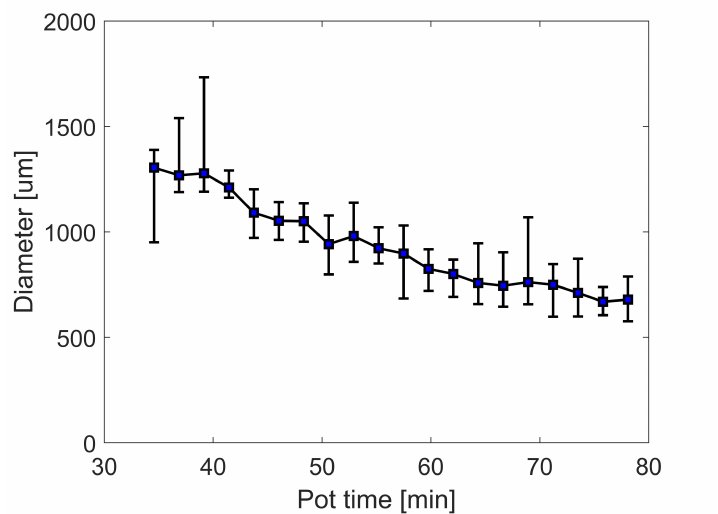
Figure 4. Correlation between pot time of room temperature curing adhesive and diameter of dispensed adhesive dots investigated on test substrates. Average diameter of 40 dots per foil substrate dispensed at different time points (error bars represent min/max values). 20 foil substrates with 40 dots each are consecutively dispensed during 50 min after adhesive preparation (dispensing pressure 5bar, stand-off distance 150µm, dispensing time